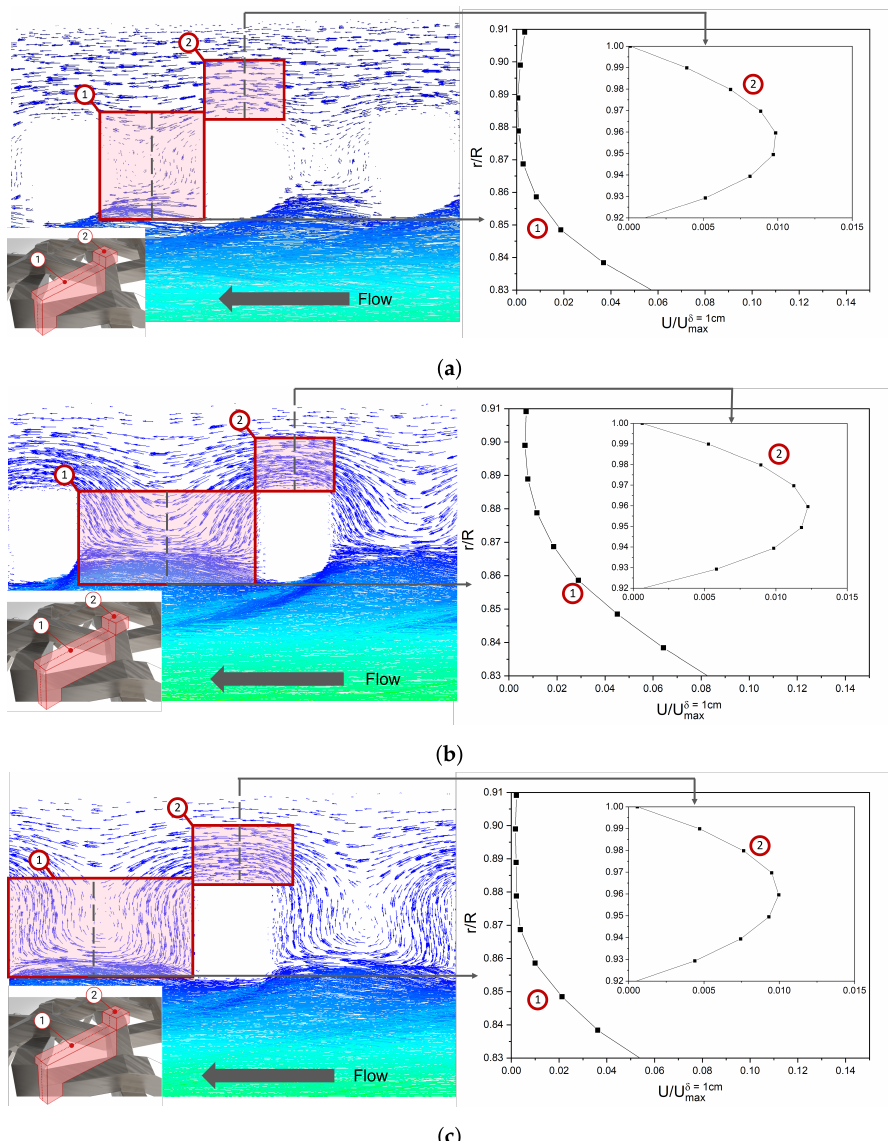
Figure 9. Velocity vectors and velocity magnitude profiles in laminar regime with constant δ (0.4 cm) and w equal to ( a ) 0.3 cm ( b ) 0.6 cm with WME and ( c ) 0.6 cm with